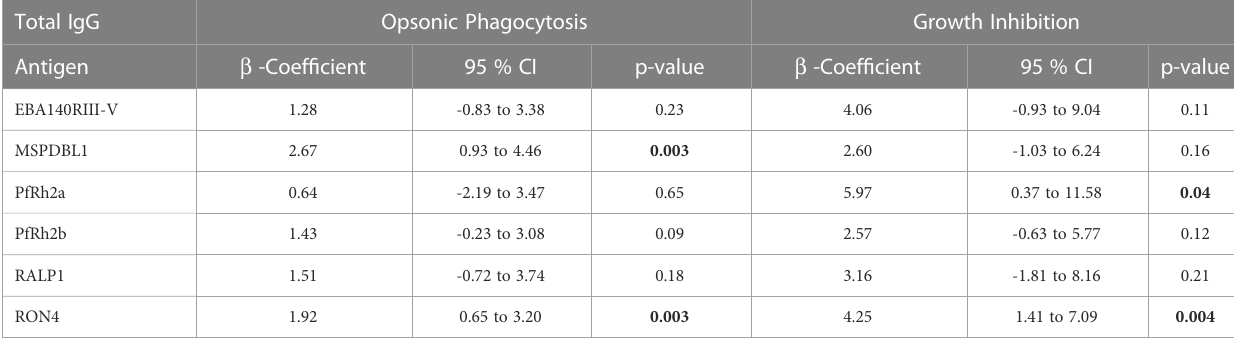
TABLE 3 Association between total IgG responses and opsonic phagocytosis and growth inhibition respectively. Total